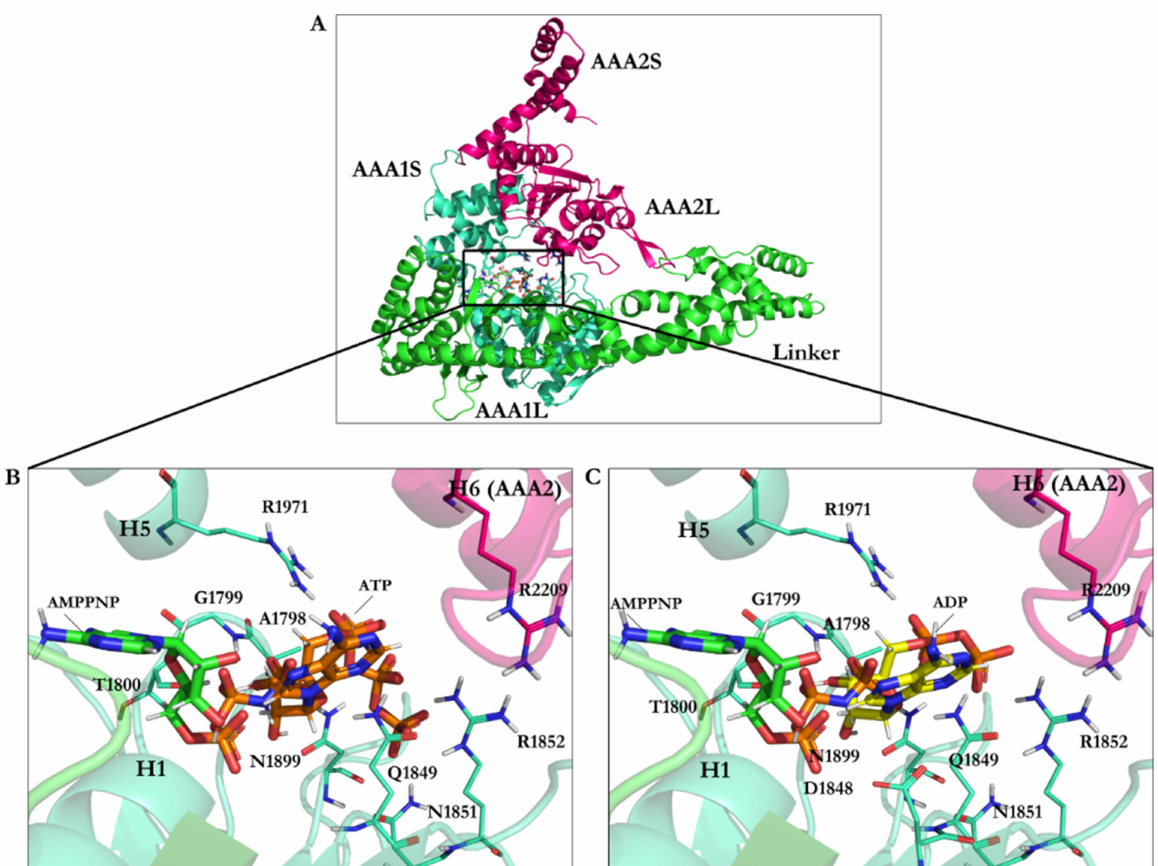
Figure 7. ( A ) The linker and the AAA1 and AAA2 subunits of dynein and illustration of their inter-subunit binding site. Binding interactions of docking solutions of ( B ) ATP (orange) and ( C ) ADP (yellow) compared to AMPPNP (green) at the AAA1 binding